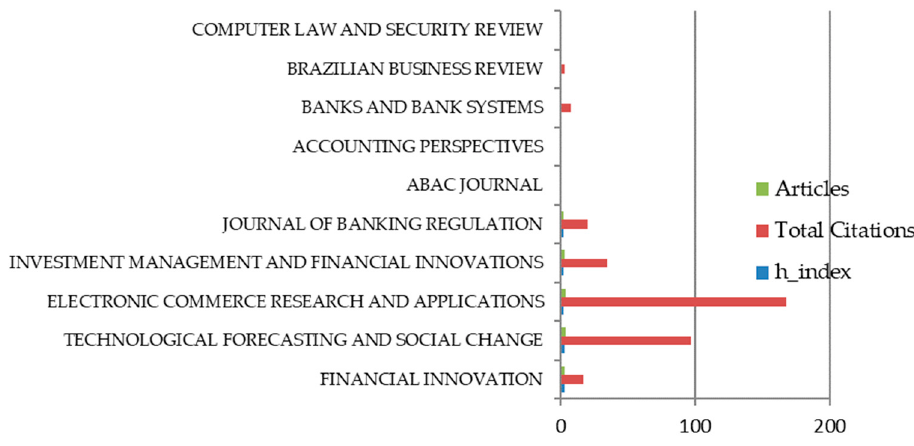
Figure 3. Journal Impact (‘Authors’ compilation).